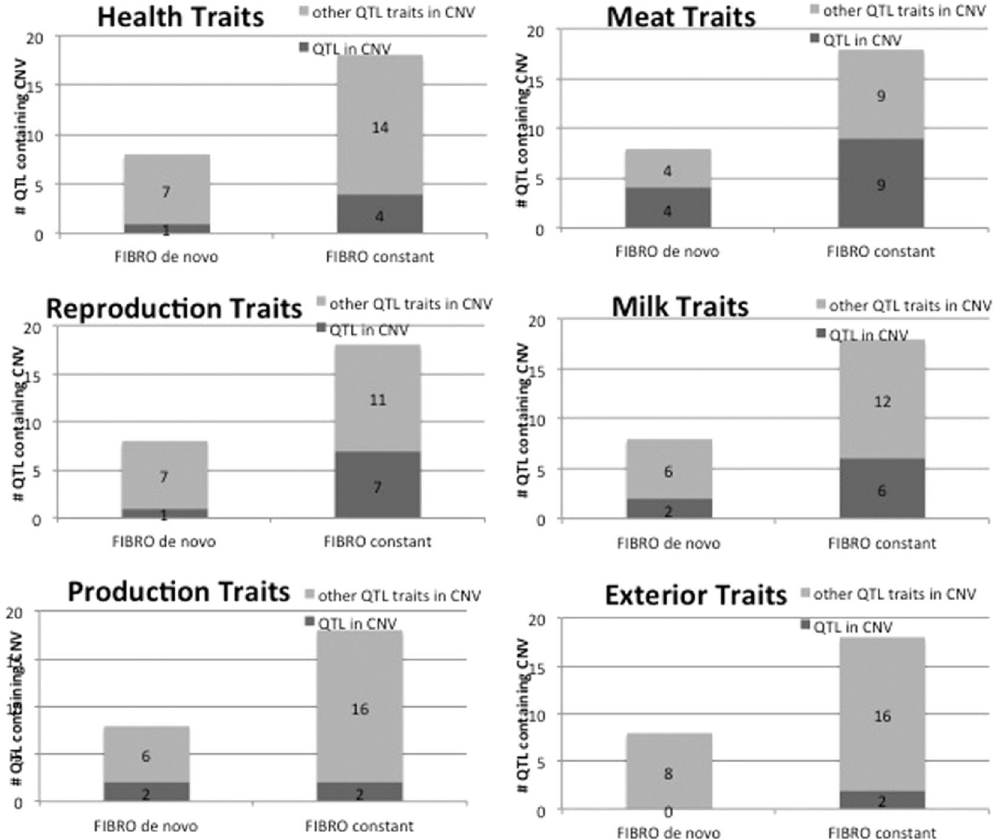
Figure 4. Number of major QTL classes assigned to the in vitro FIBRO